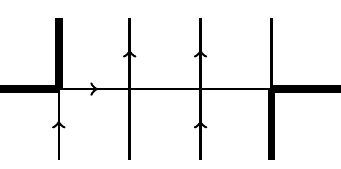
Figure 7 . A con(cid:12)guration of vertices in one row generated by the action of the transfer matrix. The vertices on the far left and far right of the (cid:12)gure correspond to vertices (9) and (35) in (cid:12)gure 6. The Boltzmann weights of these two vertices can be found in tables 1 and 3 respectively where we observe that both of them have a * beside them, meaning that their signs are opposite to the signs of the corresponding vertices of the staggered six vertex model. The two minus signs cancel each other out. More generally, the periodic boundary conditions ensure that there are will always be an even number of vertices with opposite signs in the two